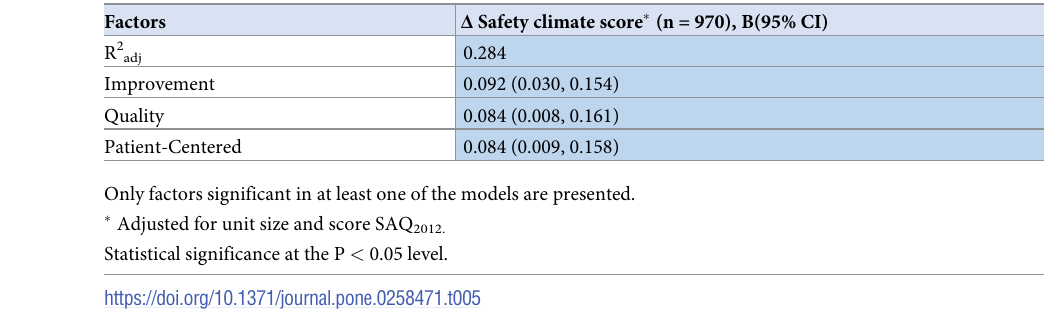
Table 5. Work environment factors most significantly associated with a change in climate score. Factors